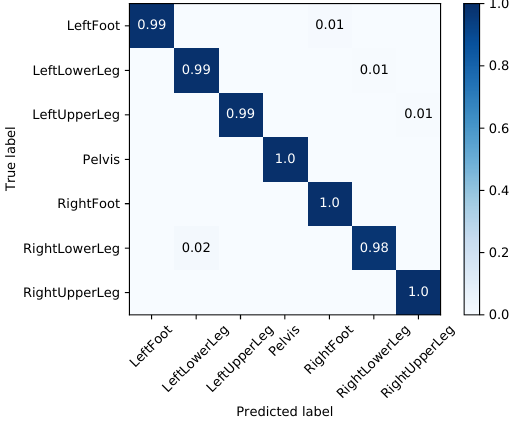
Figure A4. I2S assignment problem, final model: test person from dataset B , IMU configuration 3 (cf. Table A7). Average accuracy: